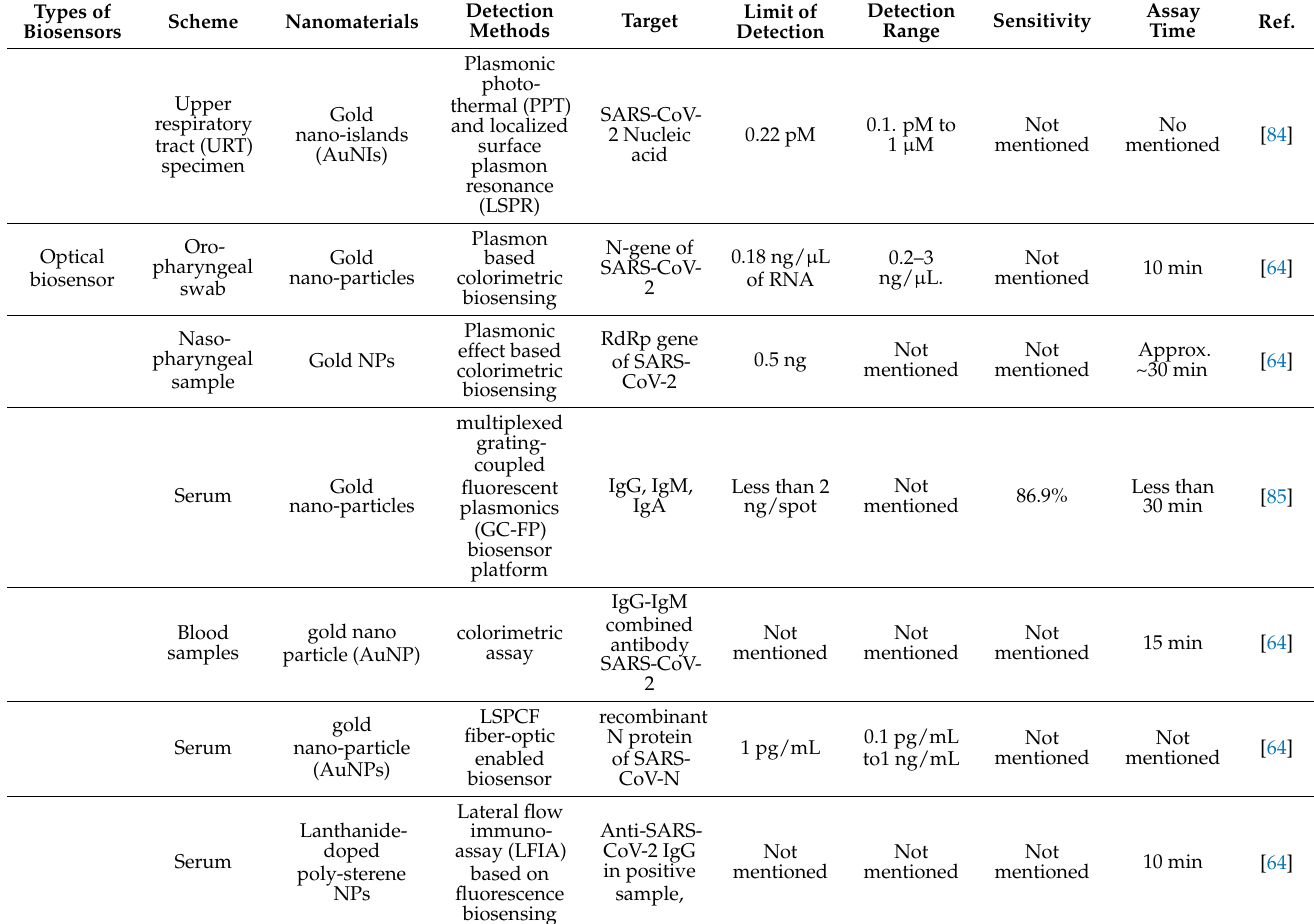
Table 2. Methods and properties of biosensors being used for the detection of COVID-19. Types of Biosensors